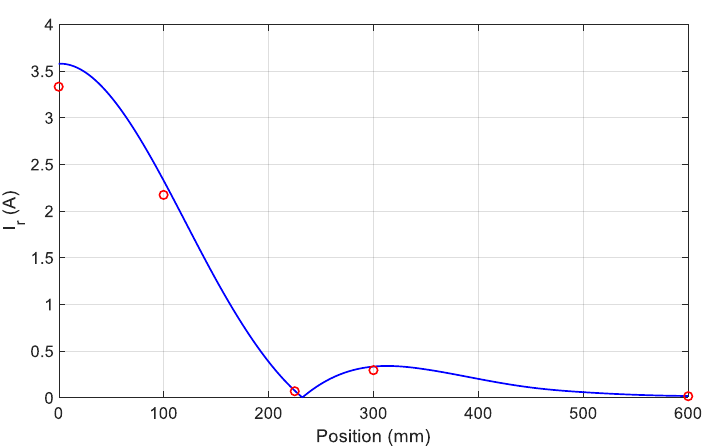
Figure 8. Current amplitude in the receiving coil obtained from FEM (red circles) and by the independent circuit (blue line).